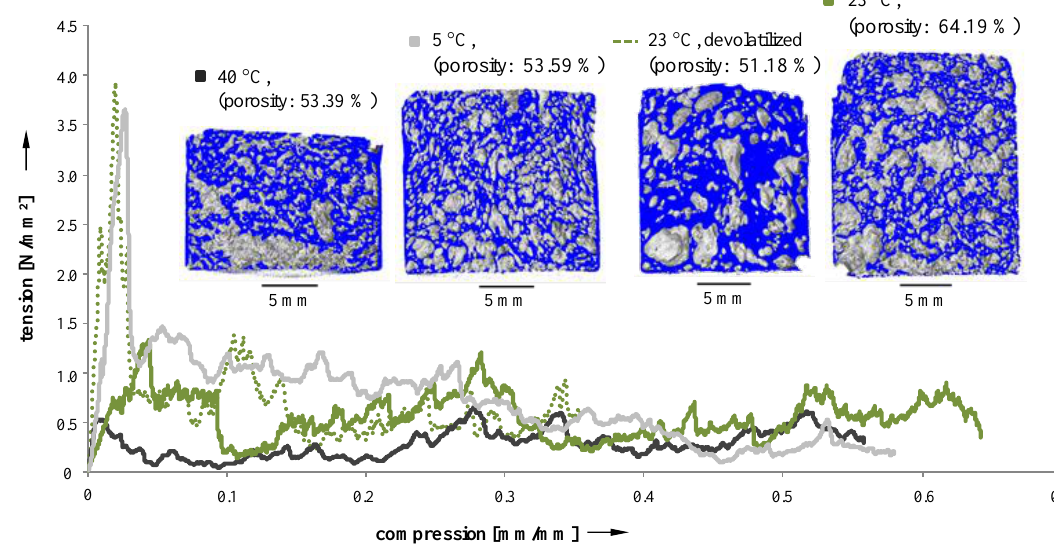
Figure 10. Compression tests on sintered samples (40 °C suspension; 5 °C suspension; devolatilized 23 °C suspension; 23 °C suspension).